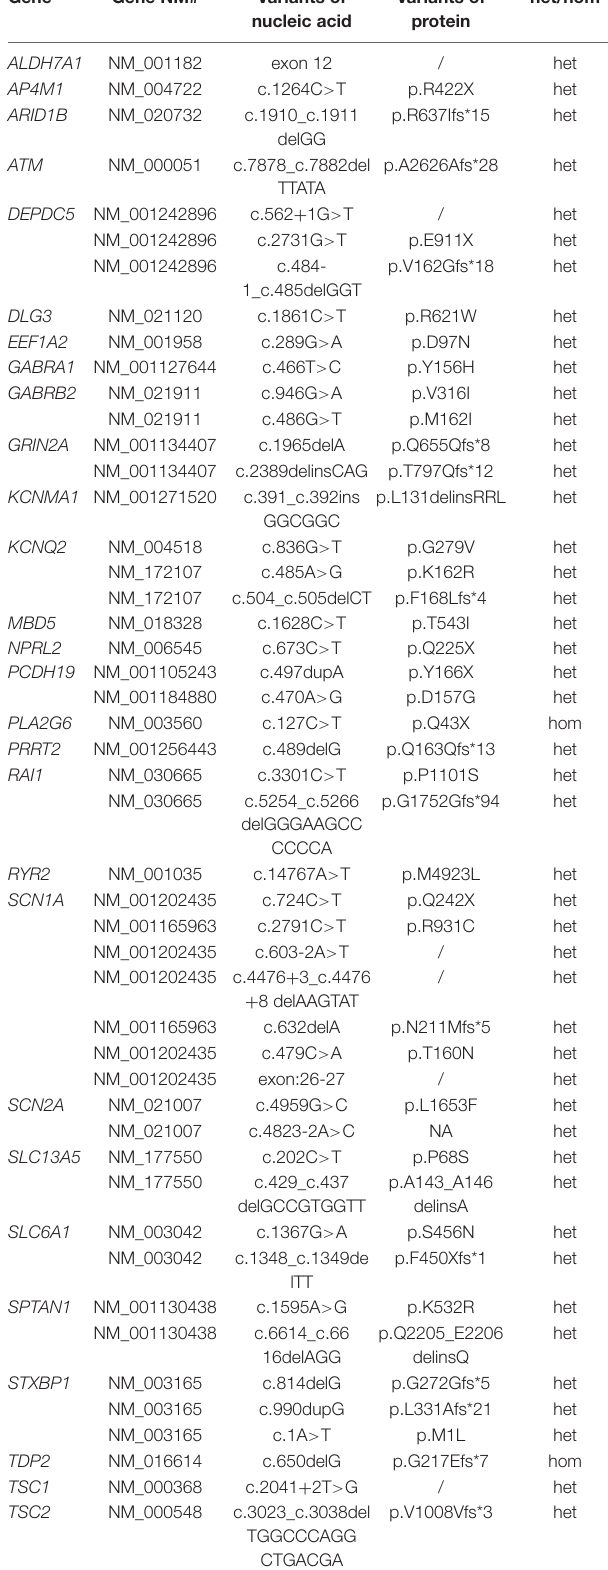
TABLE 3 | Forty-eight novel pathogenic or likely pathogenic variants. Gene Gene